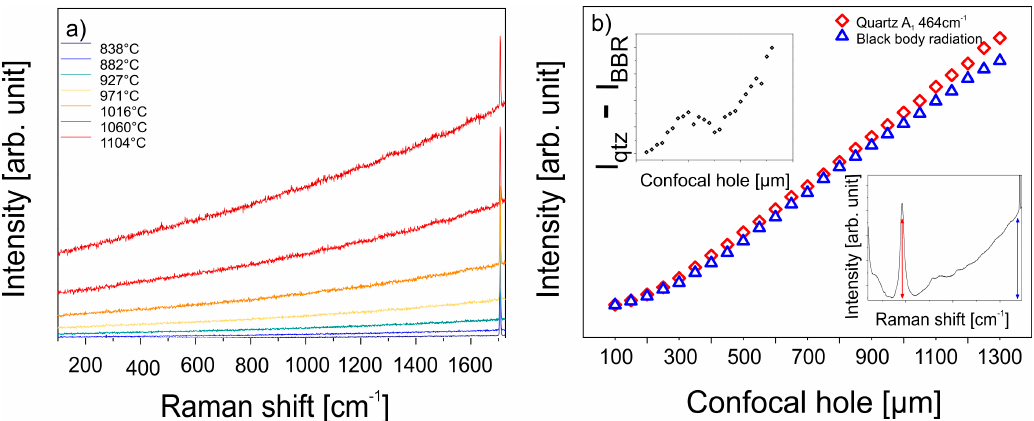
Figure 5. ( a ) The black body radiation as a function of temperature. ( b ) The Raman intensity of the A 1 quartz band near 464 cm − 1 (lower inset diagram) and the intensity of the black body radiation at 1100 °C as a function of the confocal pinhole.